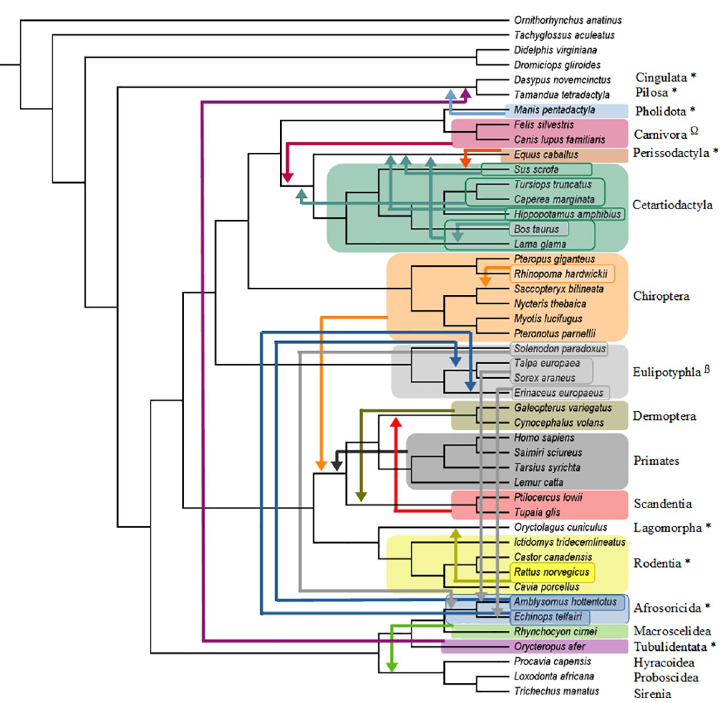
Fig 3. Summary of molecular scaffold + fossil taxa analyses. Summary of the pseudoextinction results for the O’Leary et al. [31] data set for one of our seven sets of analyses (molecular scaffold + fossil taxa). Orders that were recovered in phylogenetic positions that conflict with the molecular scaffold are indicated by arrows. Any shifts of individual species are also indicated by arrows. All analyses found a single most parsimonious tree (MPT) except for Eulipotyphla and Sirenia, each of which had two most parsimonious reconstructions. One MPT for Eulipotyphla supported Epitheria (Afrotheria + Boreoeutheria), as shown above, while the second MPT supported Exafroplacentalia (Xenarthra + Boreoeutheria). One MPT for Sirenia supported Epitheria (Afrotheria + Boreoeutheria), as shown above, while the second MPT supported Atlantogenata (Xenarthra + Afrotheria). In both cases the relationships for the pseudoextinct Eulipotyphla and Sirenia were unchanged between their two MPTs. Only six orders (32%) (Proboscidea, Sirenia, Lagomorpha, Hyracoidea, Cingulata, Pilosa) remained in the correct interordinal position when pseudoextinct. � = MPT supports Atlantogenata, ß = MPT supports Chiroptera as sister to Ferae (Carnivora + Pholidota), O = MPT supports Chiroptera as sister to Pholidota.